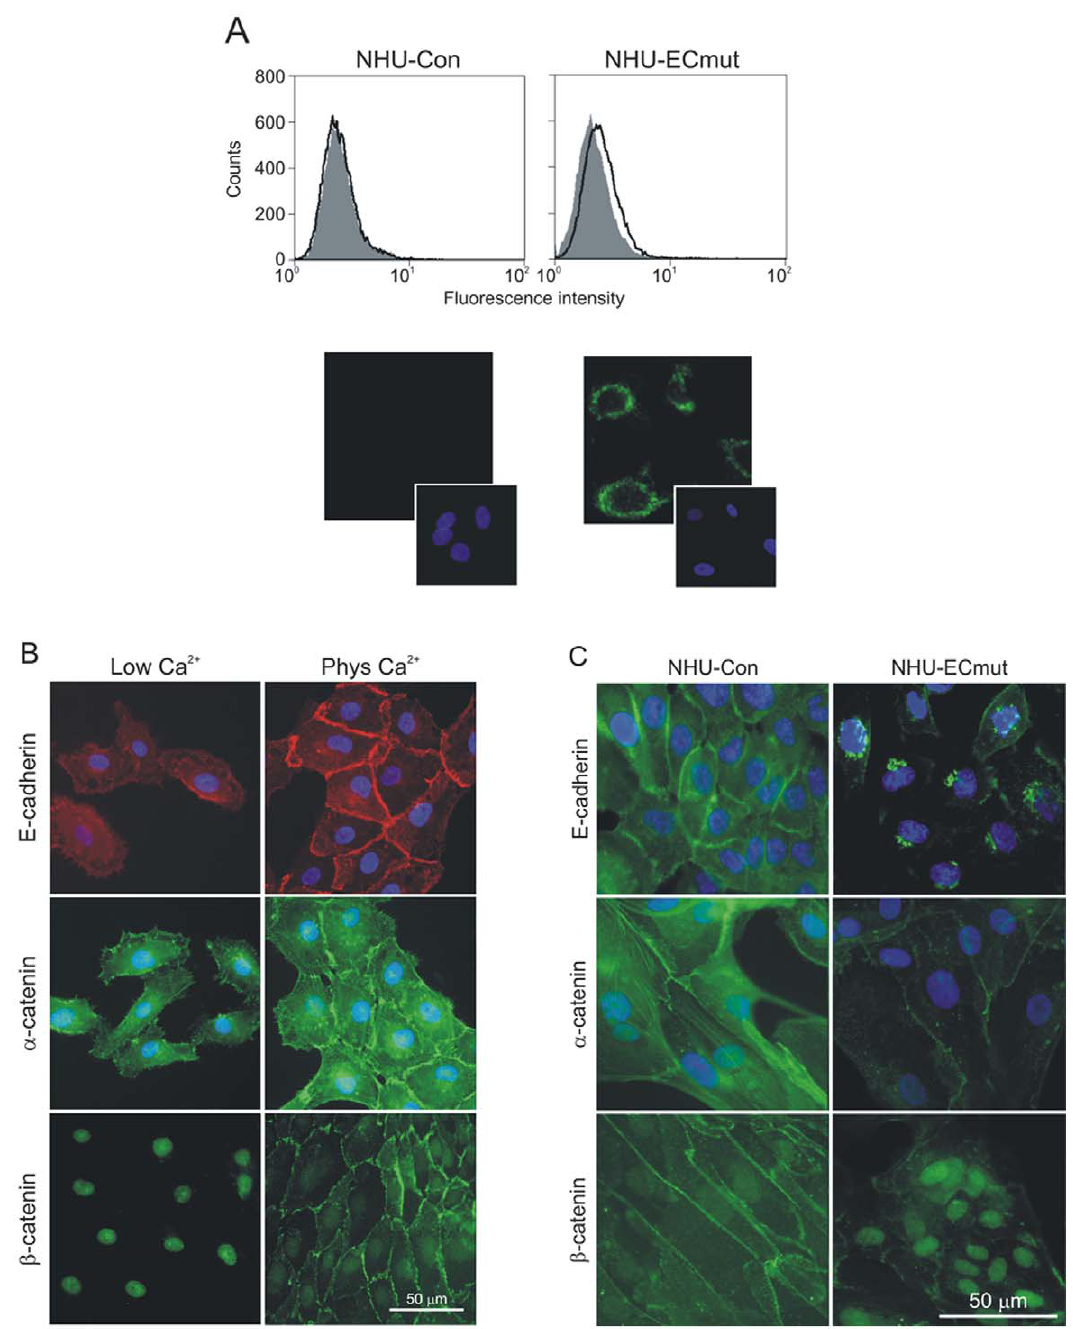
Figure 3. Effect of dominant-negative mutant E-cadherin on expression and localisation of endogenous E-cadherin and catenins in NHU cells. (A) NHU cells expressing the H-2K d -E-cad mutant (NHU-ECmut) and their isogenic controls (NHU-Con) were established by retrovirus transduction and expression of mutant E-cadherin was assessed by flow cytometry and immunofluorescence microscopy. For flow cytometry (upper panels), expression was analysed using FITC-conjugated anti-H-2K d antibody (open histograms) alongside irrelevant isotype-matched control antibody (filled histograms). Histograms represent log 10 fluorescence intensity in the FL-1 channel. For immunofluorescence microscopy (lower panels), expression was detected using anti-H-2K d antibody followed by goat anti-mouse antibody conjugated with Alexa Fluor 488 (green). (B) Following initial seeding, NHU cells were cultured in medium containing low (0.09 mM) or physiological (2.0 mM) Ca 2 + concentrations for 24 hours before expression of E-cadherin, a -catenin and b -catenin was assessed by microscopy using mouse (E-cadherin) and rabbit (catenins) antibodies, followed by goat antisera conjugated with Alexa Fluor 488 (green) or 594 (red). (C) NHU-Con and NHU-ECmut cells were cultured in medium containing physiological [Ca 2 + ] and expression of E-cadherin, a -catenin and b -catenin was determined by labelling using primary antibodies above, followed by Alexa Fluor 488-conjugated antibody (green). In all immunofluorescence microscopy experiments, cell nuclei were visualised by labelling with Hoechst 33258 (blue).